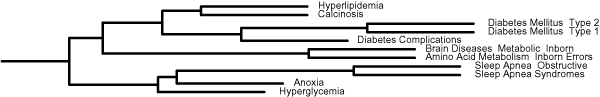
The diabetes cluster. As etiological factors, type 1 diabetes mellitus and type 2 diabetes mellitus share similar disease profiles with calcinosis, hyperlipidemia, sleep apnea, and inborn errors of metabolism. Branches are shown shorter here and in Figure 3 as compared to Figure 1, to improve readability of text. The branching patterns and relative lengths of branches are identical to Figure 1.